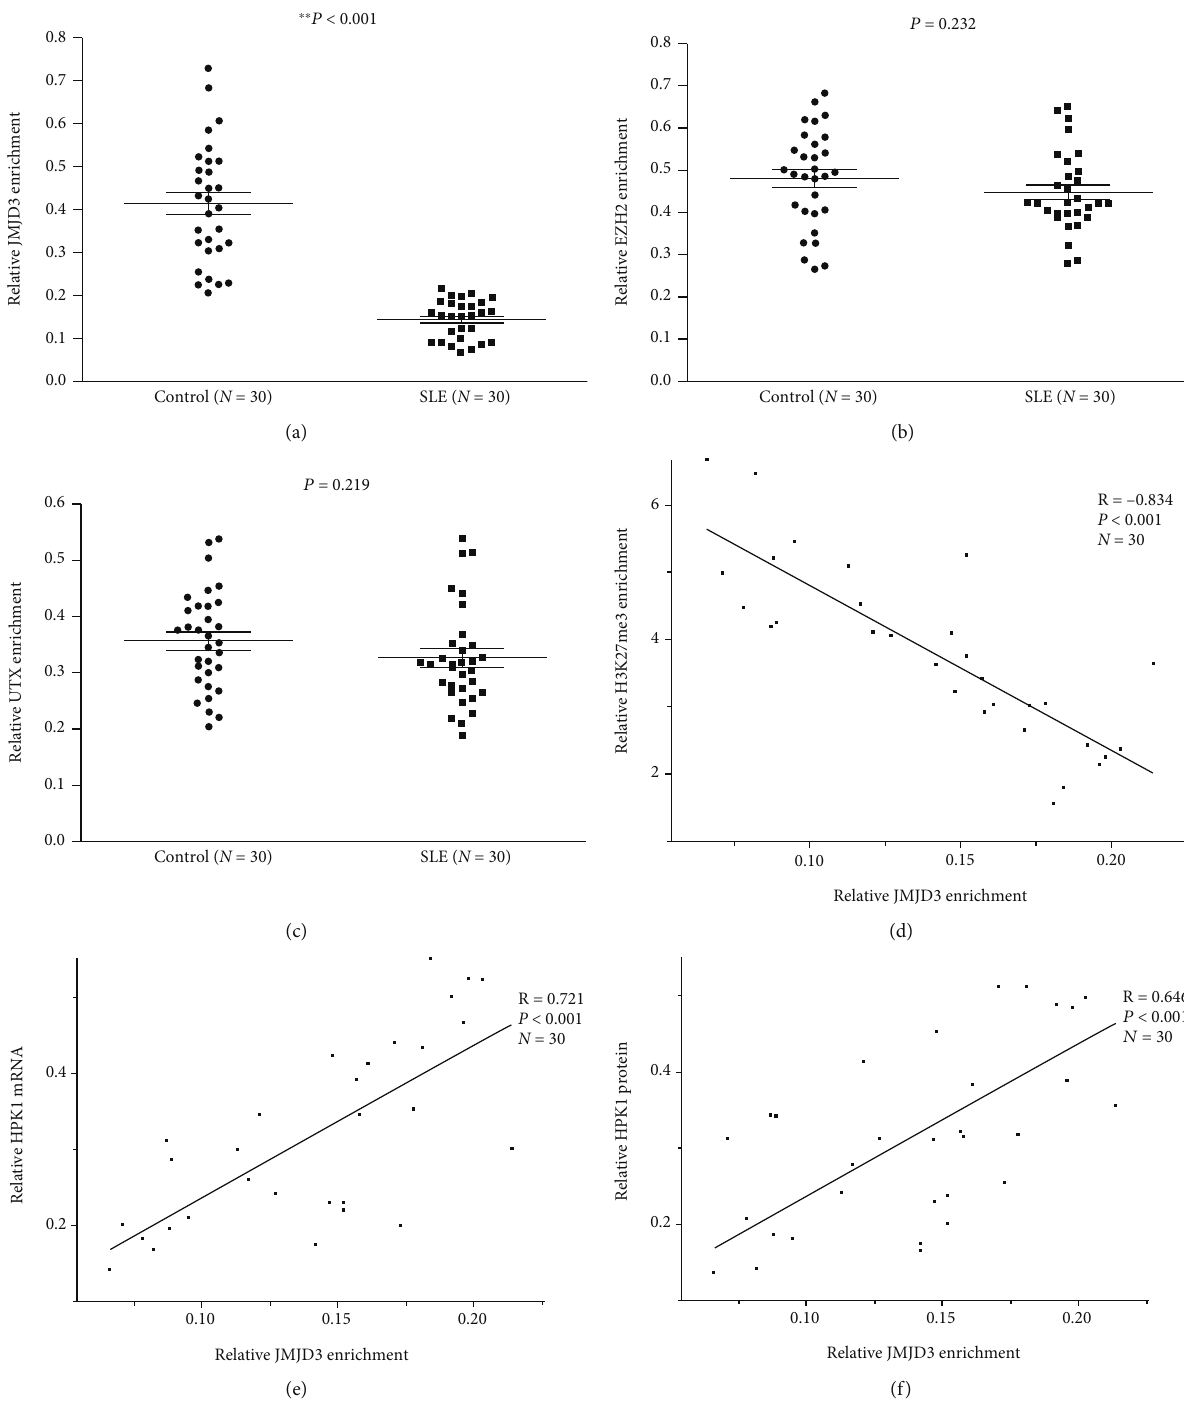
Figure 2: JMJD3, EZH2, and UTX bindings at the HPK1 promoter in healthy and SLE Tfh cells. (a – c) Relative levels of JMJD3 (a), EZH2 (b), and UTX (c) binding within the HPK1 promoter region in healthy and SLE Tfh cells were analyzed by combining ChIP and qPCR assays. Results were normalized to input DNA (total chromatin). (d – f) The correlations between H3K27me3 enrichment (d), HPK1 mRNA level (e), protein level (f), and JMJD3 binding in SLE Tfh